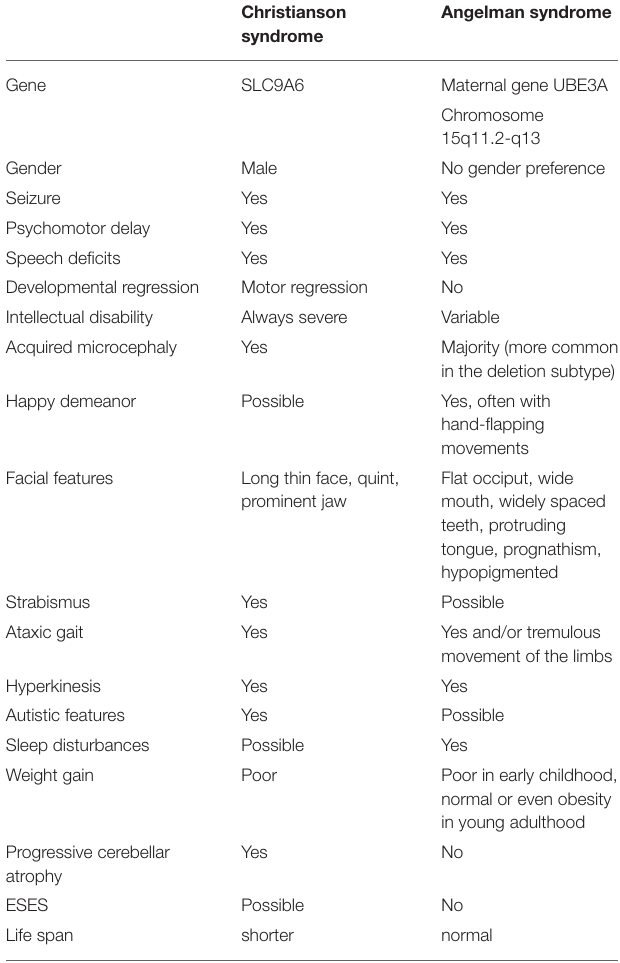
TABLE 1 | Differential characteristics between Christianson syndrome and Angelman